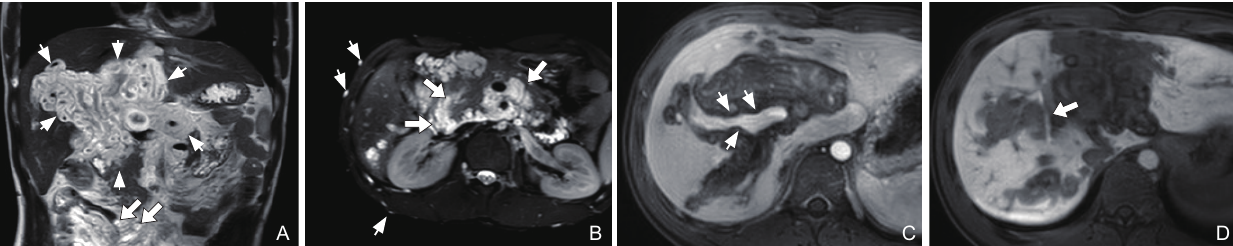
Figure 2 Upper-abdomen magnetic resonance imaging (MRI). (A) Coronal T2-weighted image shows a widely infiltrative high signal intensity mass- like lesion (arrowheads) extending along intrahepatic ducts into liver, and proliferating inferior to mesentery (arrows). Central target sign and whorled appearance could be observed; (B) Axial SPAIR shows extensive tumor involvement in the pancreas (arrows). Multiple cutaneous nodules(arrowheads) could also be observed; (C) CE-MRI demonstrates low signal intensity of tumor at portal phase (65s after EOB injection). The portal vein presents serpentine and compressed by surrounding tumor (arrowheads); (D) An unobstructed intrahepatic bile duct (arrow) could be detected at hepatobiliary phase (15min after injection).